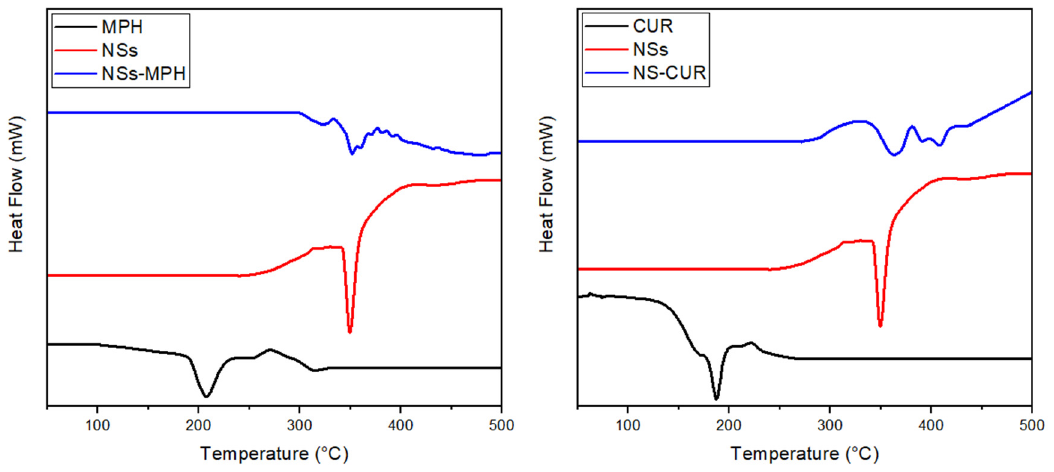
Figure 10. DSC thermograms of MPH, CUR, NSs, NSs–MPH, and